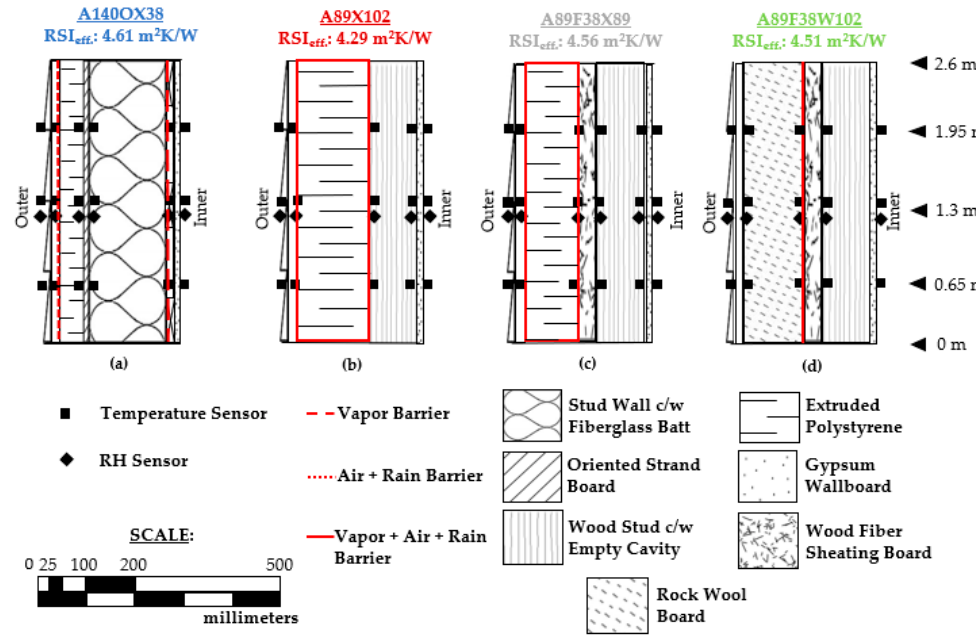
Figure 3. ( a ) An A140OX38 assembly, which is composed of a 140-mm insulated structural cavity with 38-mm extruded polystyrene, an internal vapor barrier and an external rain and air control layer; ( b ) an A89X102 assembly, which is composed of an 89-mm non-insulated structural cavity and 102-mm extruded polystyrene that acts as a thermal, vapor, rain and air control layer; ( c ) an A89F38X89 assembly, which is composed of an 89-mm non-insulated structural cavity, 38-mm fiberboard and 89-mm extruded polystyrene that acts as a thermal, vapor, rain and air control layer; ( d ) an A89F38W102 assembly, which is composed of an 89-mm non-insulated structural cavity, 38-mm fiberboard and 102-mm semi-rigid Rockwool board. The effective thermal resistance was calculated according to the method that was presented by the Government of Canada [37].